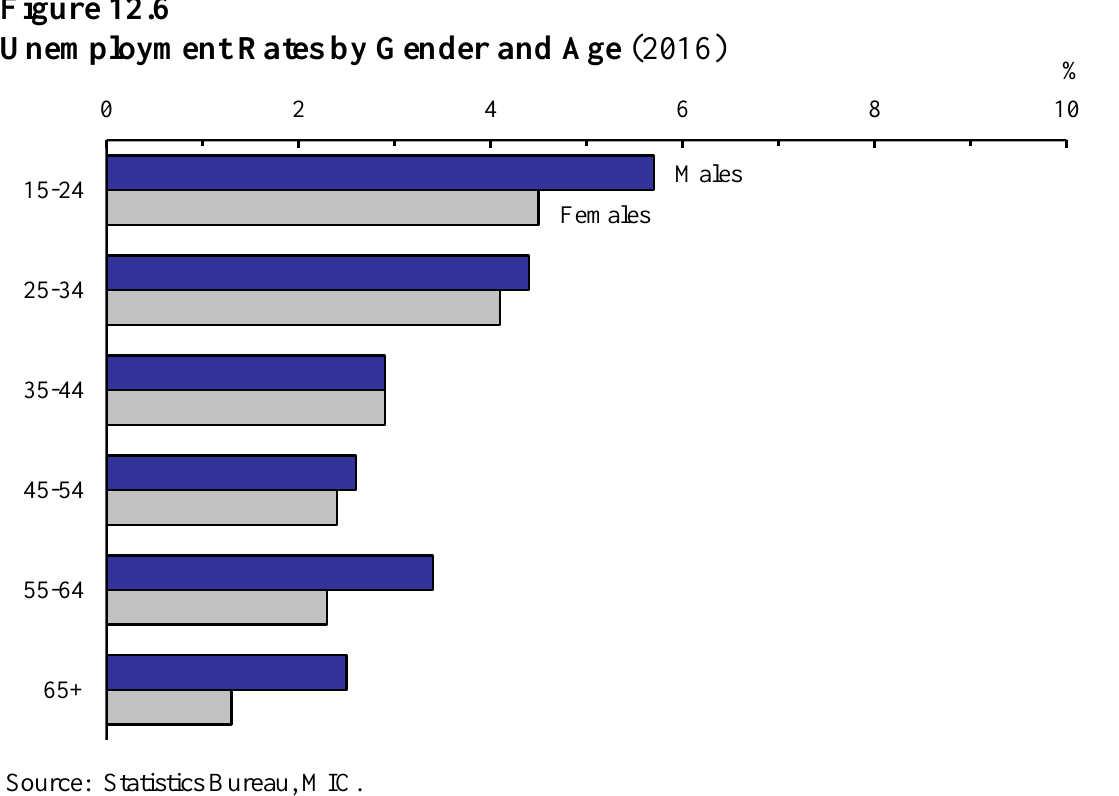
Unemployment Rates by Gender and Age (2016)